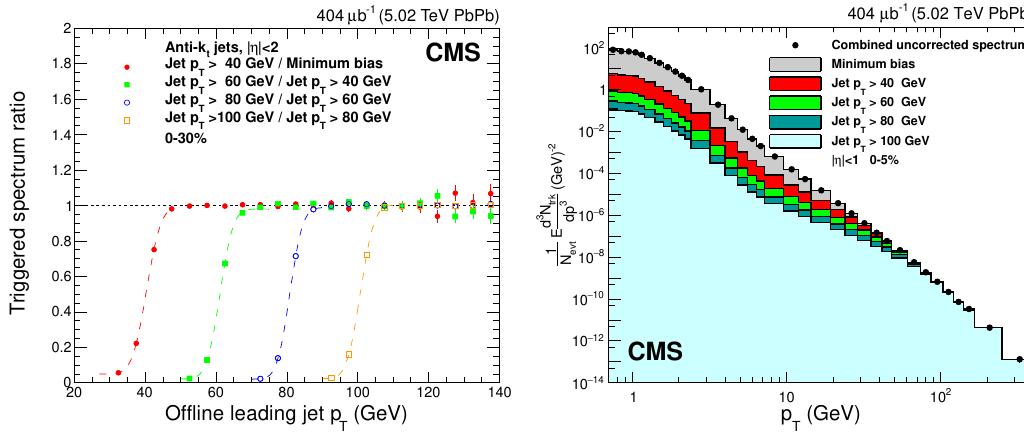
Figure 1 . Left: ratio of the leading jet p T distributions in PbPb collisions in the 0{30% centrality range from various triggers, after the data have been normalized to one another. Lines have been added to guide the eye. Right: contributions from the various jet triggers (colored histograms) to the combined, but otherwise uncorrected, track spectrum (black markers) in the 0{5% centrality range in PbPb collisions. The statistical uncertainties are smaller than the size of the data